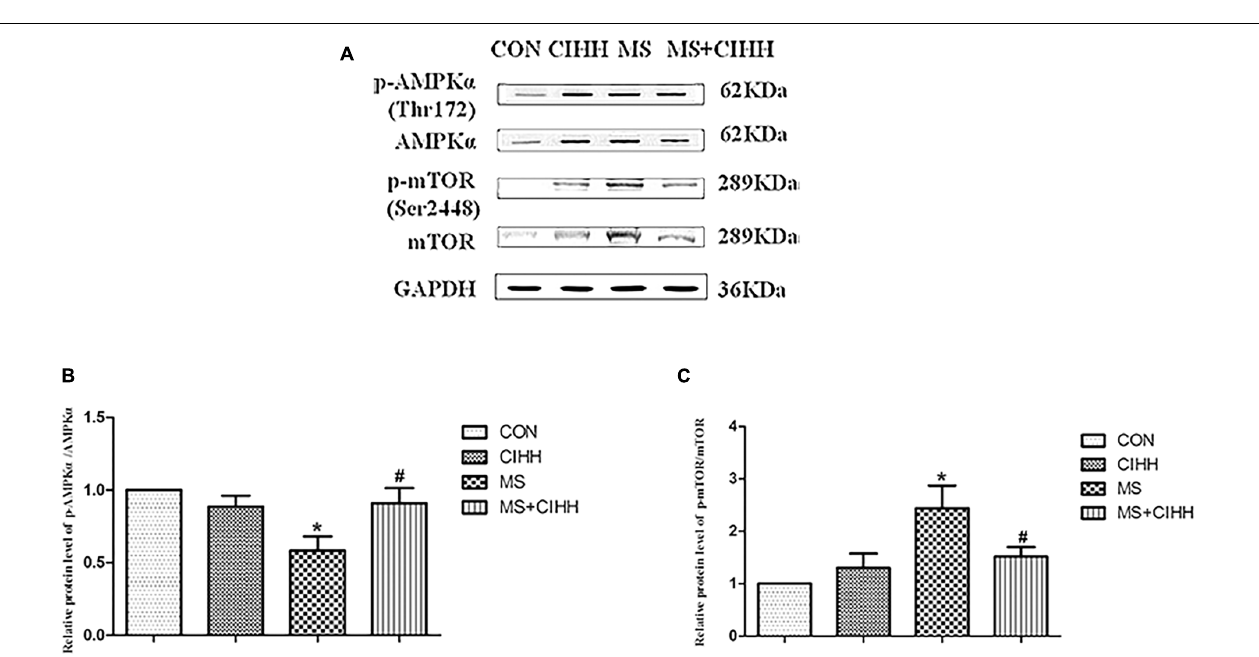
FIGURE 7 | Effect of CIHH on the phosphorylation of AMPK α (Thr172) and mTOR (Ser2448) in rat livers. (A) Original recording of Western blotting. (B) Quantification of protein levels of p-AMPK α . (C) Quantification of protein levels of p-mTOR. CON: control group, CIHH: CIHH group, MS: metabolic syndrome group, MS + CIHH: MS + CIHH group. All data were expressed as mean ± SD; n = 4 for each group. * P < 0.05 vs. CON, #P < 0.05 vs. MS.